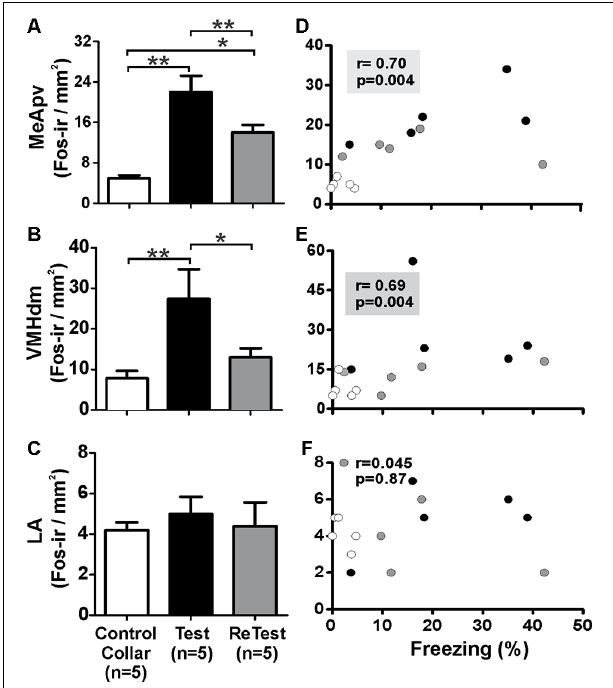
FIGURE 7 | Fos expression in the MeApv and VMHdm correlated with freezing behavior. (A–C) Quantification of Fos immunoreactive (Fos-ir) cells in the posteroventral subnucleus of the medial amygdala (MeApv), dorsomedial subnucleus of the ventromedial hypothalamus (VMHdm) and lateral amygdala (LA), respectively. Data are expressed as means + SEM. ∗ p < 0.05, ∗∗ p < 0.01. (D–F) Scatter plots showing the relation between the percentage of time spent freezing and Fos-ir neurons in the MeApv, VMHdm, and LA, respectively. Coefficients and p -values are